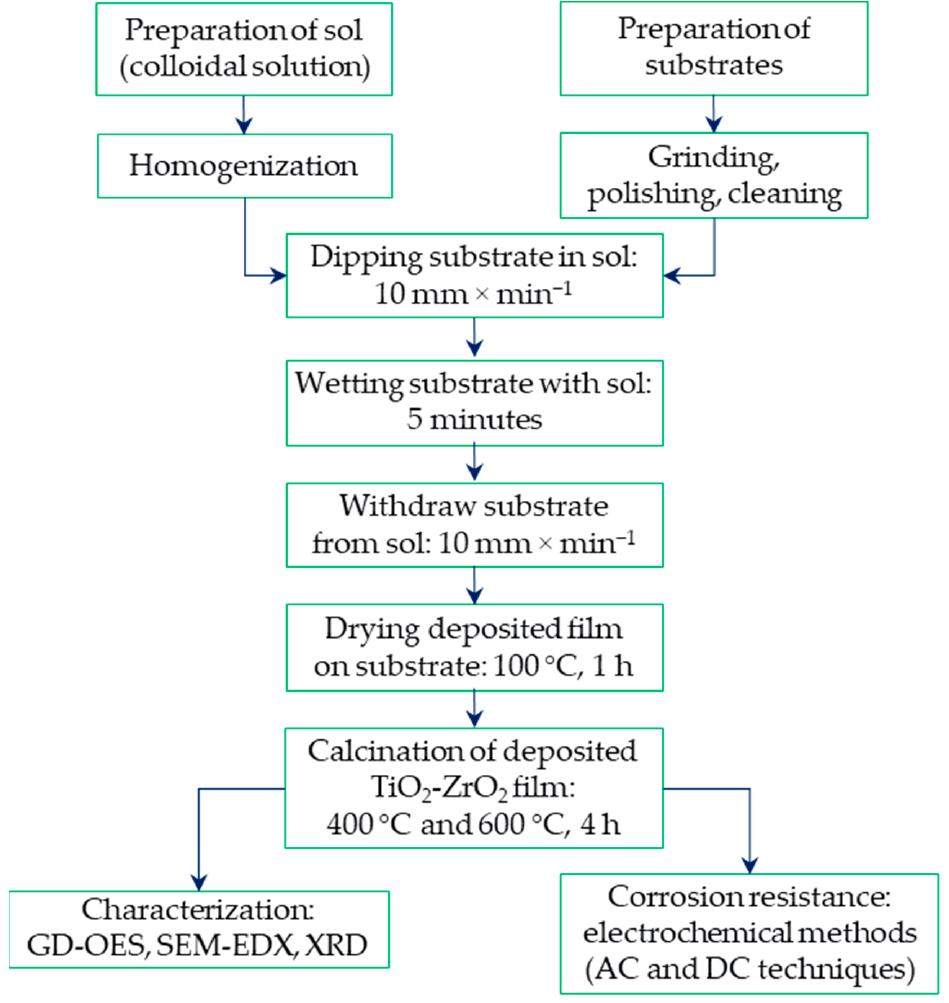
Figure 1. Flow chart for preparation and investigation of sol–gel TiO 2 –ZrO 2 films. Bulk chemical composition of AISI 316L (X2CrNiMo17-12-2, Strojopromet, Šenkovec, Croatia) stainless steel is determined by glow discharge optical emission spectroscopy (GDS 850A, Leco, Saint Joseph, MI, USA) and results in wt% are presented in Table 1. Table 1. Chemical composition of AISI 316L stainless steel.